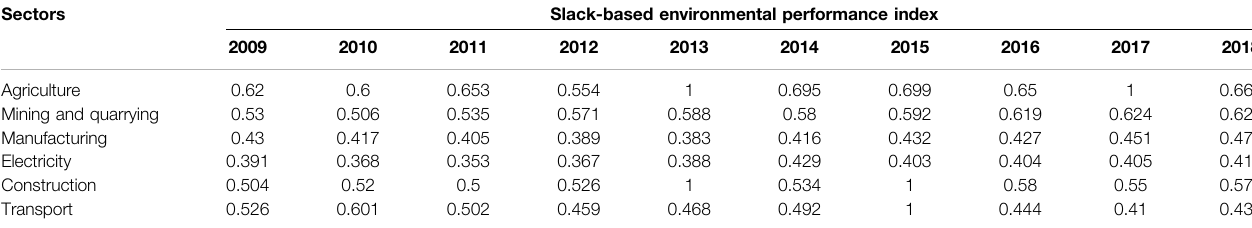
TABLE 5 | Slack-based environmental performance index for different sectors in Pakistan. Sectors